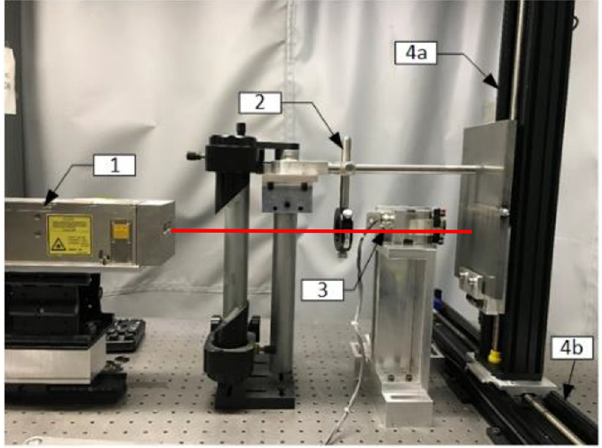
Fig. 9. Welding setup (1 – sample, 2 – positioning system, 3 – welding robot).